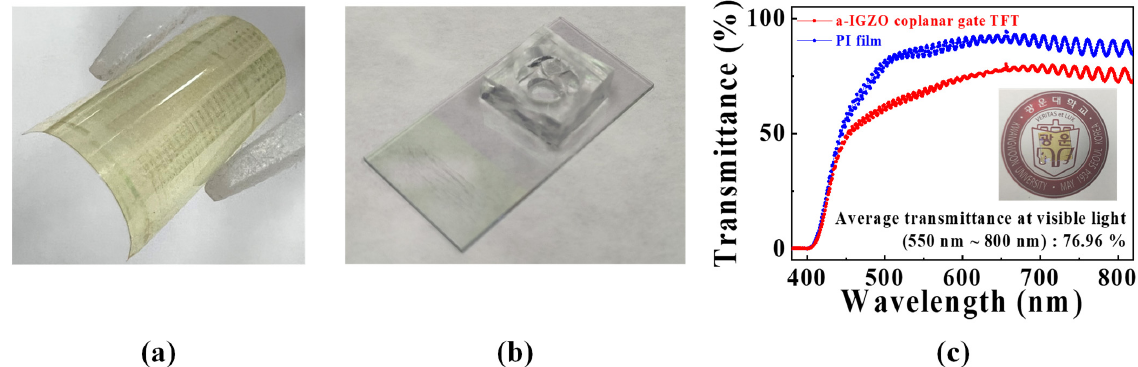
Figure 2. Photographs of the fabricated ( a ) transducer unit and ( b ) sensing unit. ( c ) Optical transmittance spectra of the PI film and a-IGZO coplanar dual-gate TFT transducer unit. The inset shows a photograph of the fabricated transparent transducer unit. The average transmittance at visible light (wavelength 550–800 nm) of the device is 76.96 %.